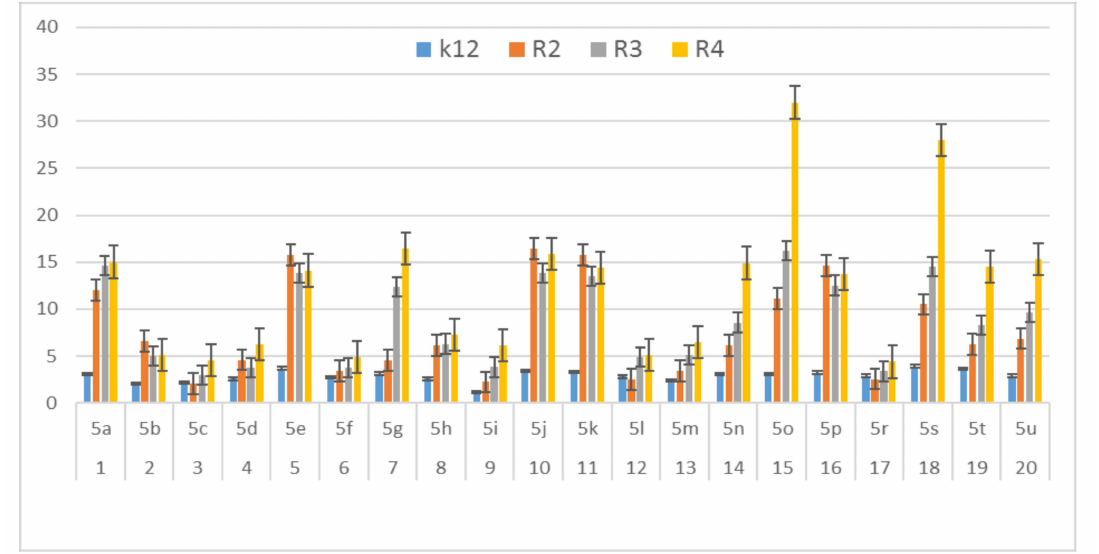
Figure 5. MBC of the α -amidoamids for the analysed strains of Escherichia coli K12 and R2, R2, and R4. The x-axis compounds 5a – 5u were used sequentially. The y-axis shows the MBC value in mg mL − 1